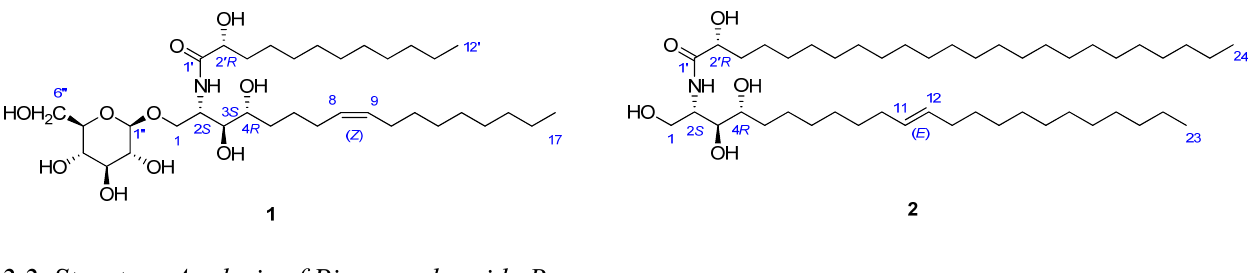
Figure 1. Structures of two new sfingolipids (pipercerebrosides) from the leaves of Piper betle